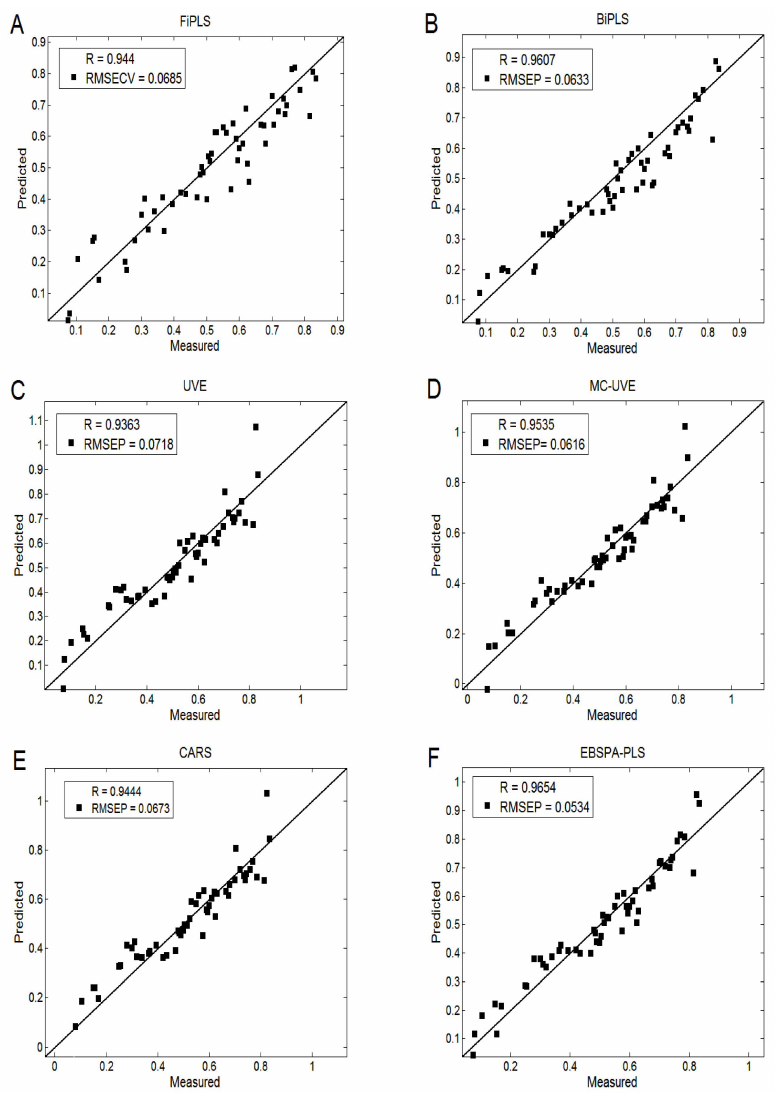
Figure 6. Comparison of regression rates: ( A ) FiPLS; ( B ) BiPLS; ( C ) UVE; ( D ) MC-UVE; ( E ) CARS; and ( F )